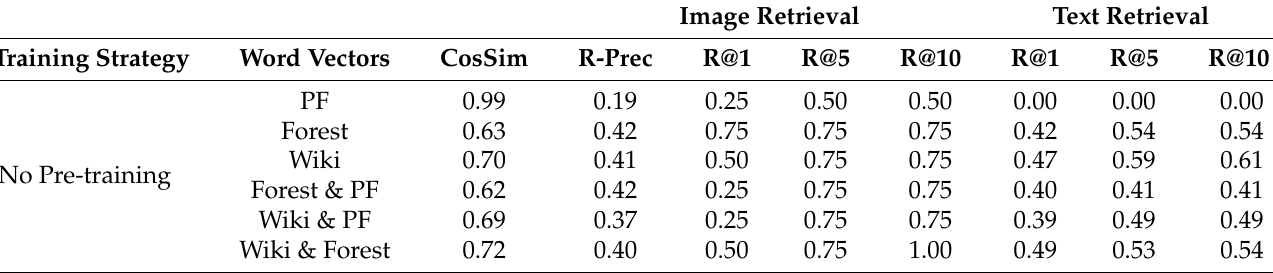
Table 3. Training the visual semantic model only on the second (post-change) image yields lower values for recall at k for the text retrieval (annotation prediction task), but it improves image retrieval scores. When the same visual semantic embedding model was trained on a single image taken after the change event, it reached lower scores than when trained on the image pair, for all the corpora, in text retrieval. The model performs better in image retrieval than when trained on the image